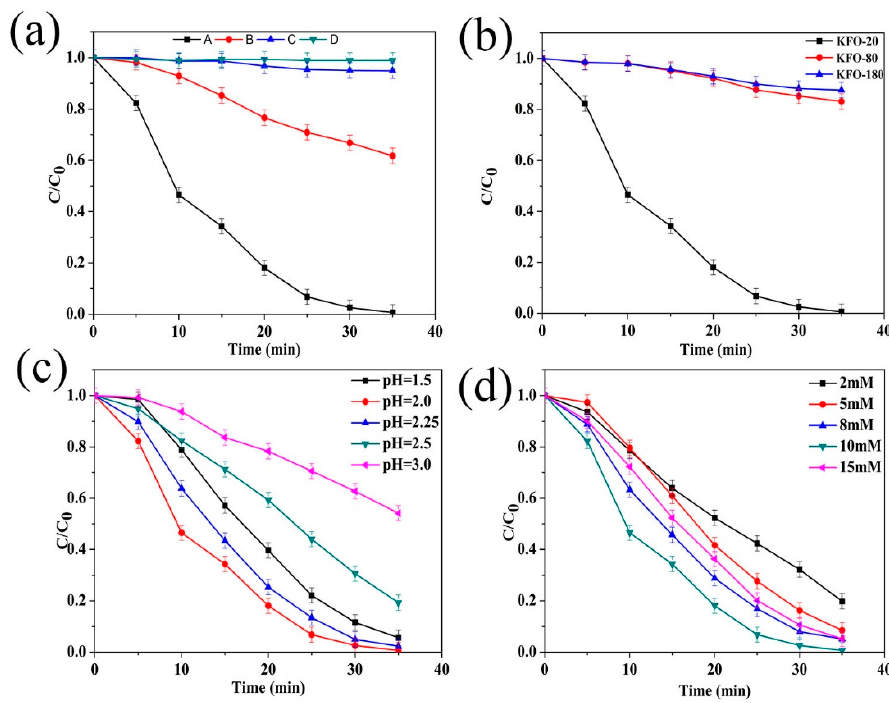
Figure 4. ( a ) Degradation efficiency of methylene blue (MB) under different conditions. A: MB + KFO-20 + H 2 O 2 + light; B: MB + KFO-20 + H 2 O 2 ; C: MB + H 2 O 2 + light; D: MB + KFO-20 + light; ( b ) degradation efficiency of MB using KFO catalysts with different sizes; ( c ) degradation efficiency of MB at different pH values; ( d ) degradation efficiency of MB at various H 2 O 2 concentrations. Reaction conditions: MB concentration, 20 mg/L; KFO mass, 30 mg; H 2 O 2, 10 mM; reaction time, 35 min.